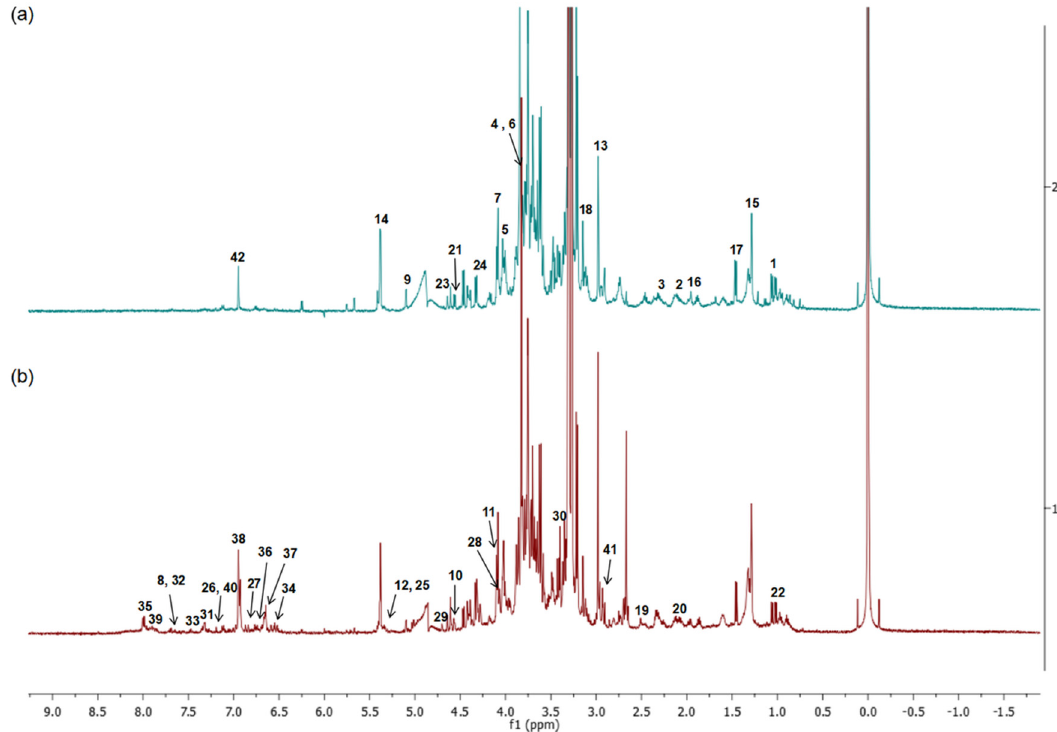
Figure 5. Representative 1 H NMR spectra ( − 2 to 9.0 ppm) of Clinacanthus nutans leaf ( a ) and stem ( b ) extracts. Values on the X -axis are the chemical shift (ppm) relative to TMS at 0.00 ppm.